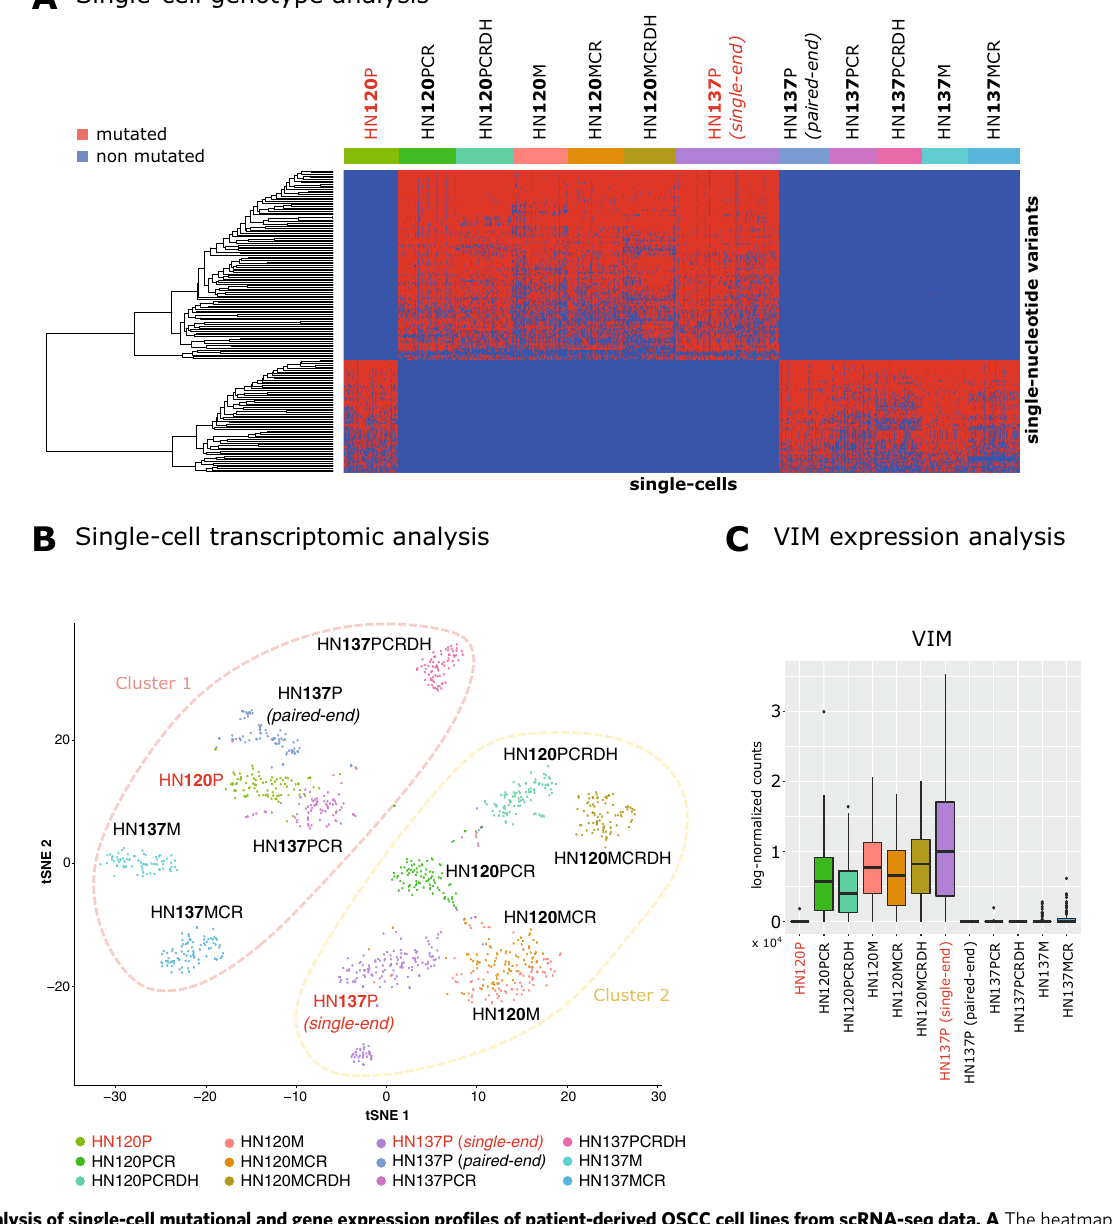
Fig. 1 Analysis of single-cell mutational and gene expression pro fi les of patient-derived OSCC cell lines from scRNA-seq data. A The heatmap including the mutational pro fi les of all single cells of the HN120 and HN137 datasets is displayed (-P: primary line, -M: metastatic line, -CR: after cisplatin treatment, -CRDH: after drug-holiday). Red entries mark cells displaying a given SNV. For the ID of single cells and SNVs please refer to Supplementary Data 1 and 2. B The t-SNE plot generated from the gene expression pro fi les of all single cells for all datasets is shown (see the SI for additional details). C The distribution of the expression level of VIM on all single cells is shown with boxplots for all